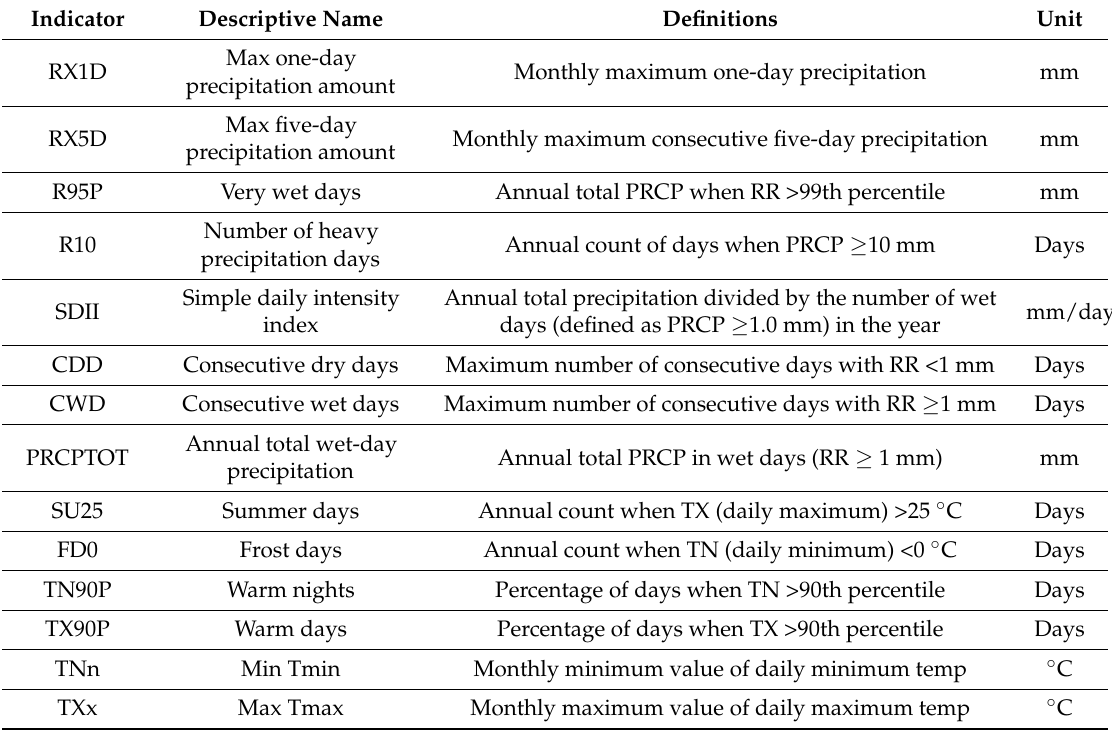
Table 1. Extreme climate indices defined by RClimDexV3 (IPCC,